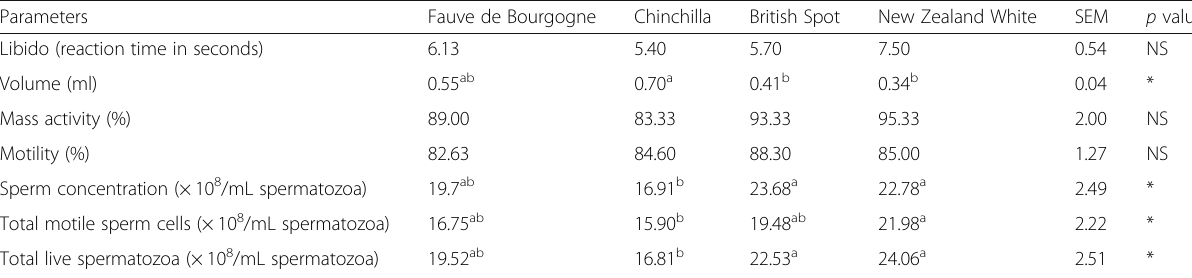
Table 1 Libido and semen characteristics of four exotic breeds of rabbit